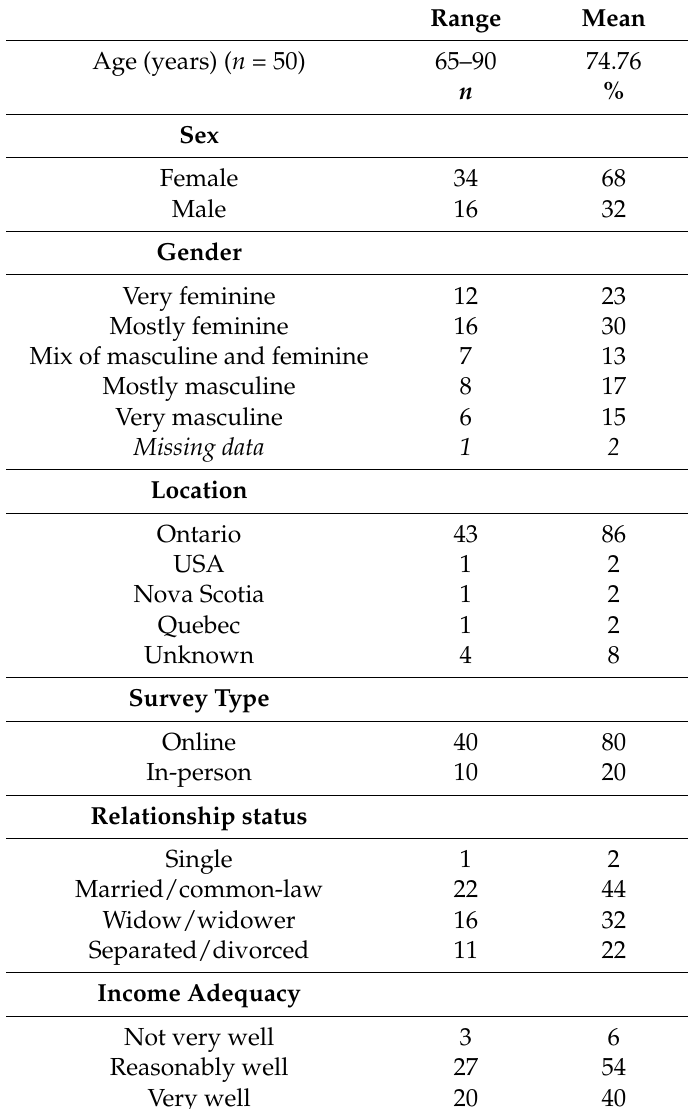
Table 1. Description of